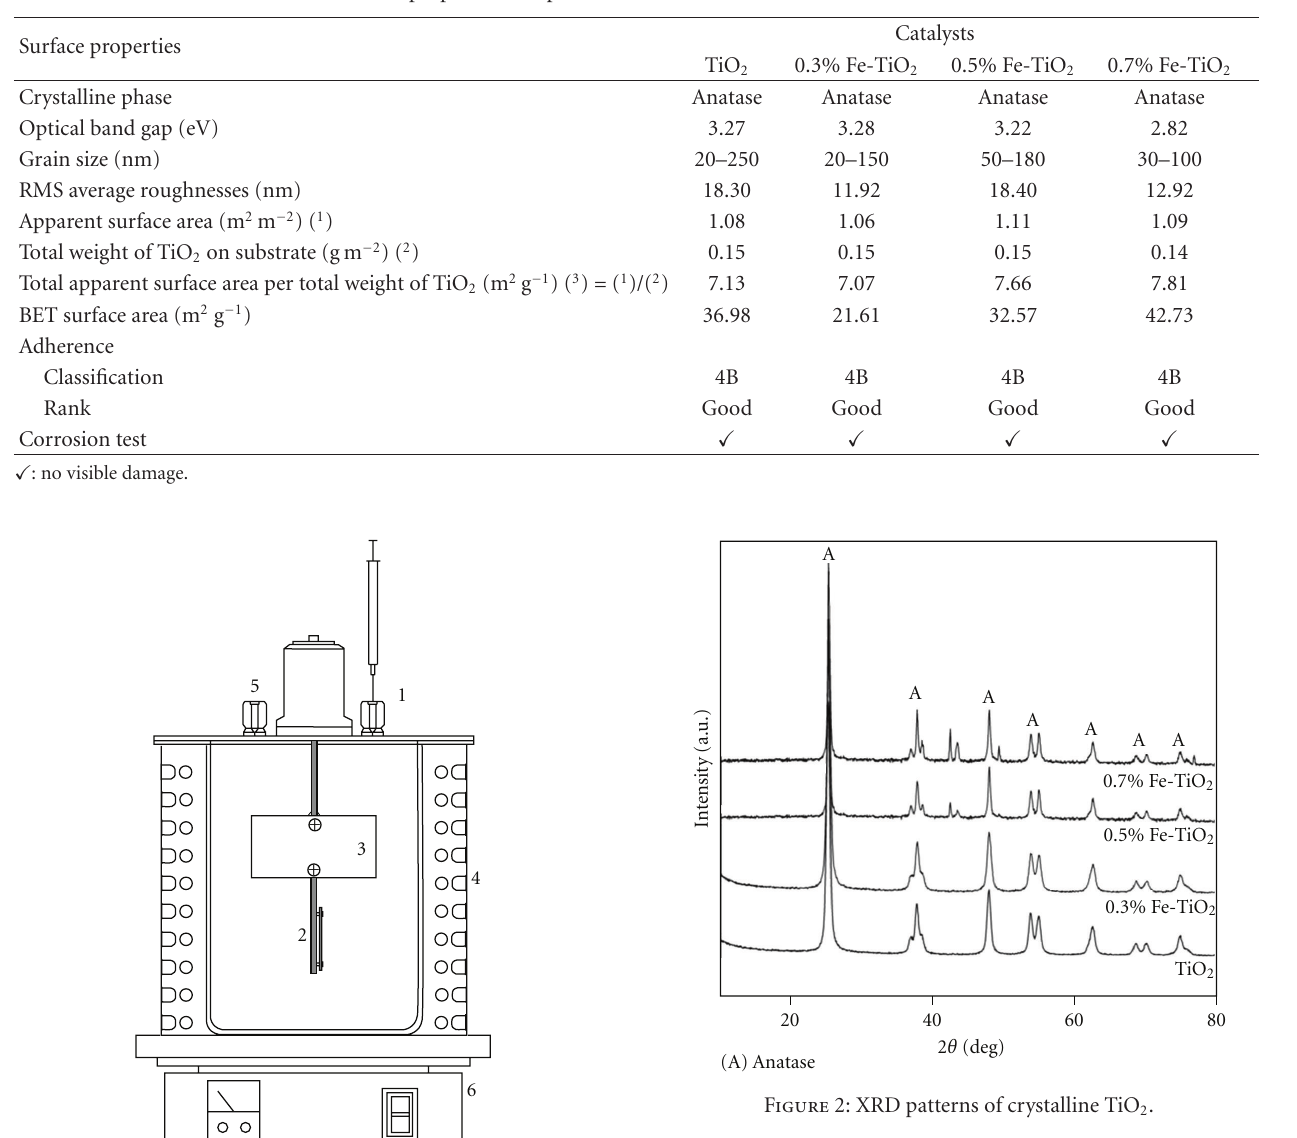
Table 1: Surface properties of dip-coated TiO 2 thin films on stainless steel substrates.